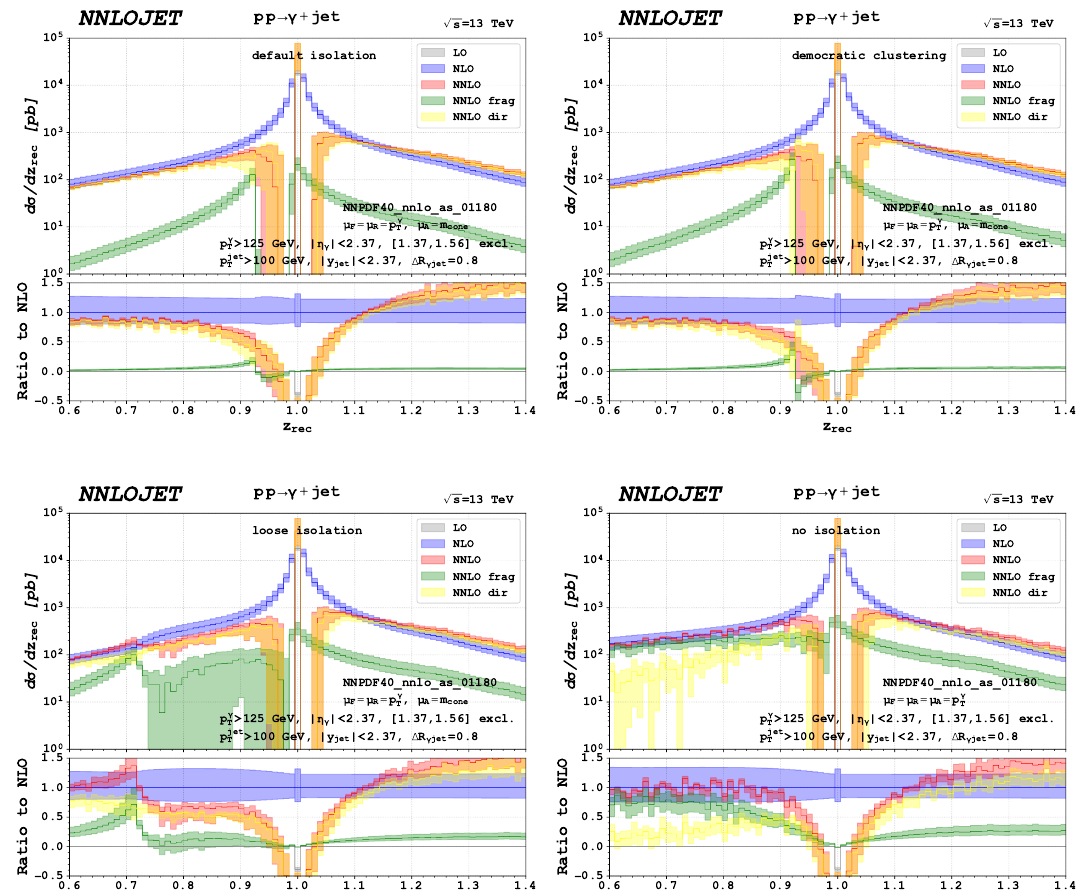
Figure 18. Decomposition of the cross section differential in z rec . Results obtained with the default isolation, a loose isolation, democratic clustering and without isolation are